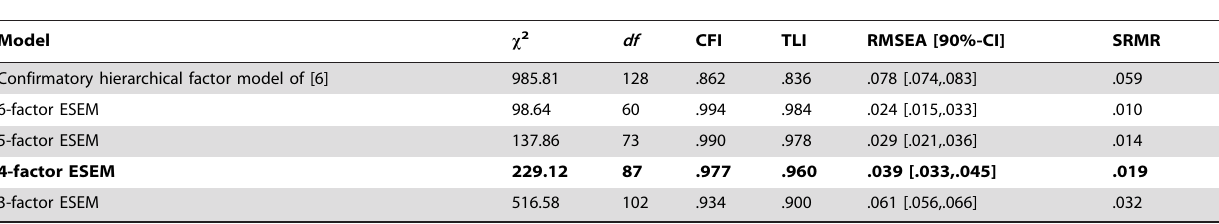
Table 3. Fit Statistics of the Higher-Order Factor Models.